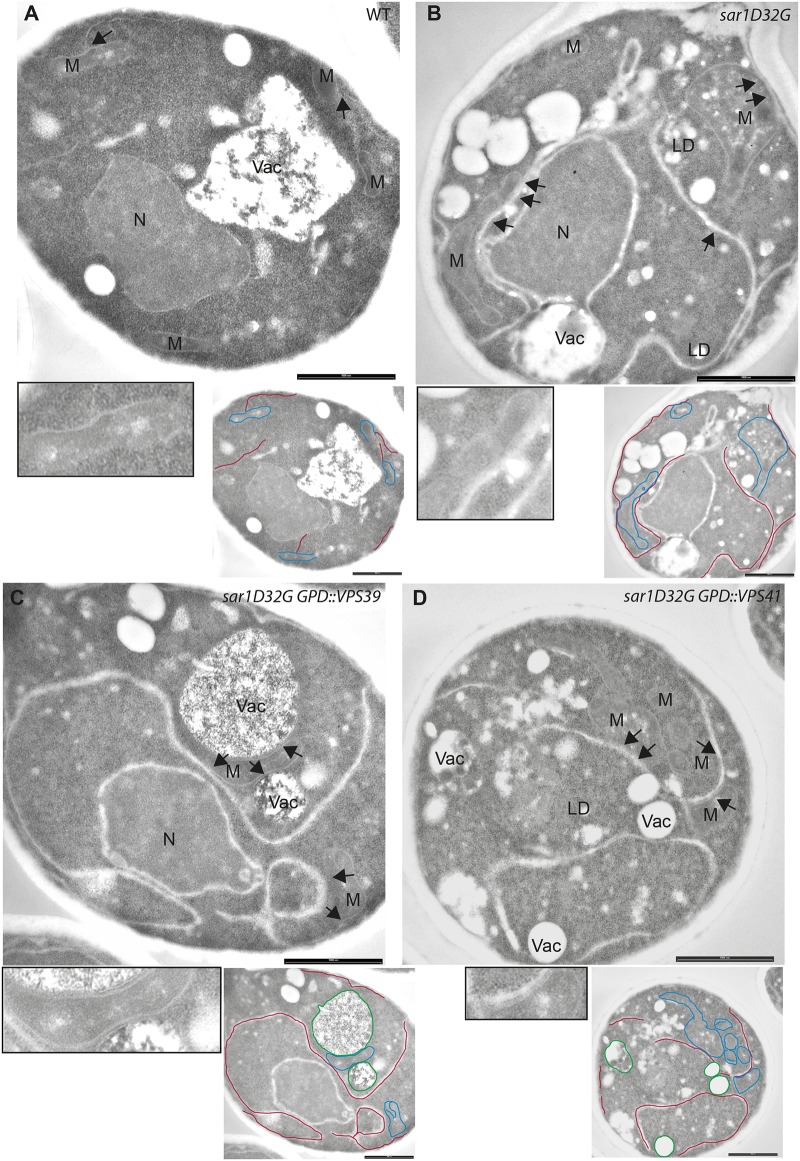
Loss of Sar1 function increases ER-mitochondria contact sites.Transmission electron microscopy images of cells of WT (A), sar1D32G (B), sar1D32G overexpressing VPS39 (C) sar1D32G overexpressing VPS41 (D) after incubation at 1 h at 37°C. The bars represent 1 μm. N: nucleus; M: mitochondria; Vac: vacuole; LD: lipid droplet. The arrows point to regions of ER mitochondria contacts. The insets represent a two-fold magnification of a region of interest. Relevant ER membranes, mitochondria and vacuoles were traced in red, blue and green, respectively, in the smaller images.